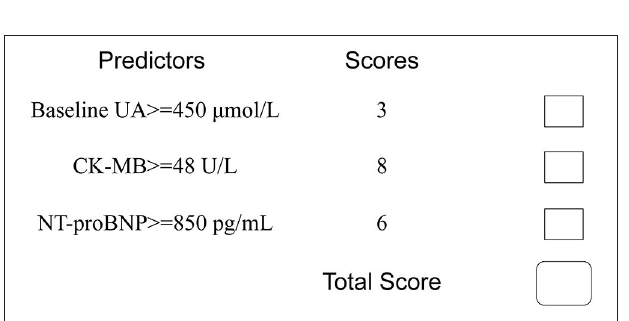
FIGURE 3 | Simplified predictive score for CIN. UA, uric acid; CK-MB, creatine kinase MB; NT-proBNP, N-terminal pro-brain natriuretic peptide.